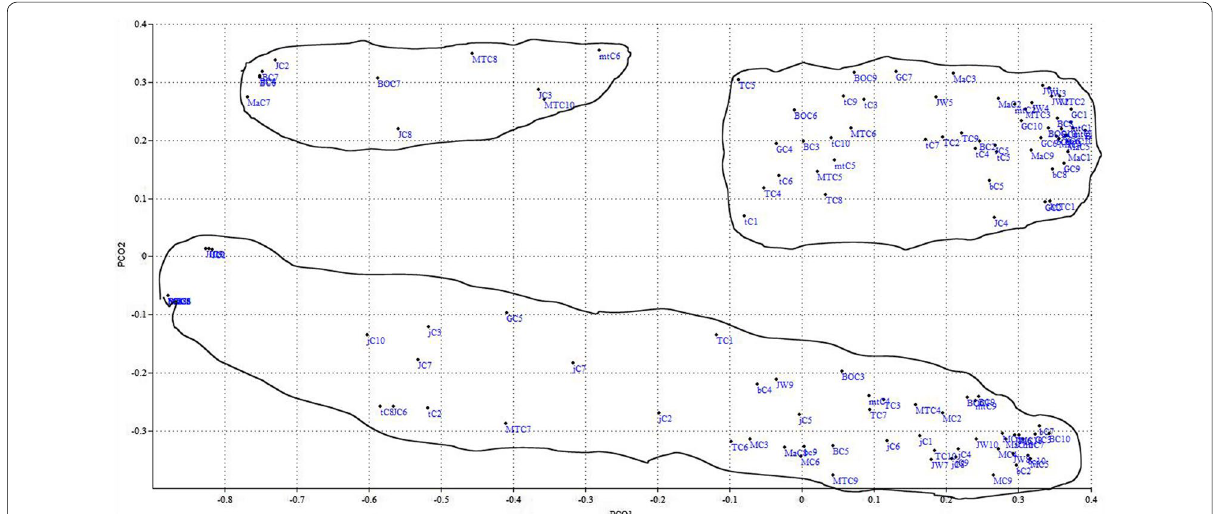
Fig. 5 Two dimensional representation (2D) of principal coordinate analysis of genetic relationships among 129 individuals of Aframomum cor- rorima from southwestern part of Ethiopia